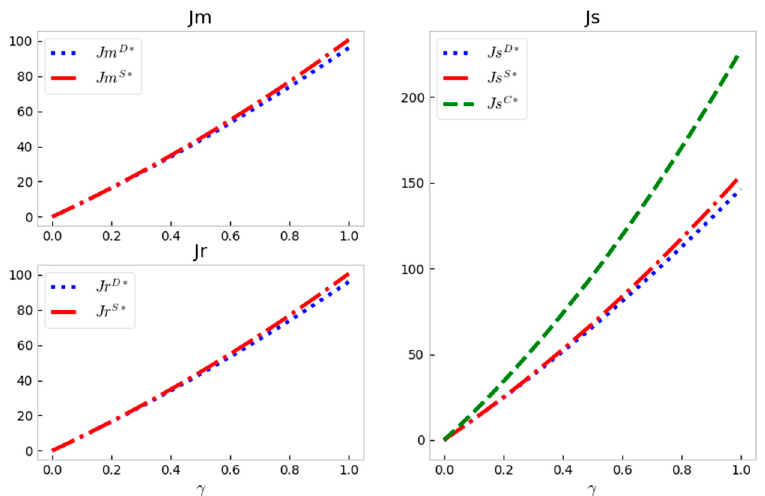
Figure 2. Impacts of γ on profits.